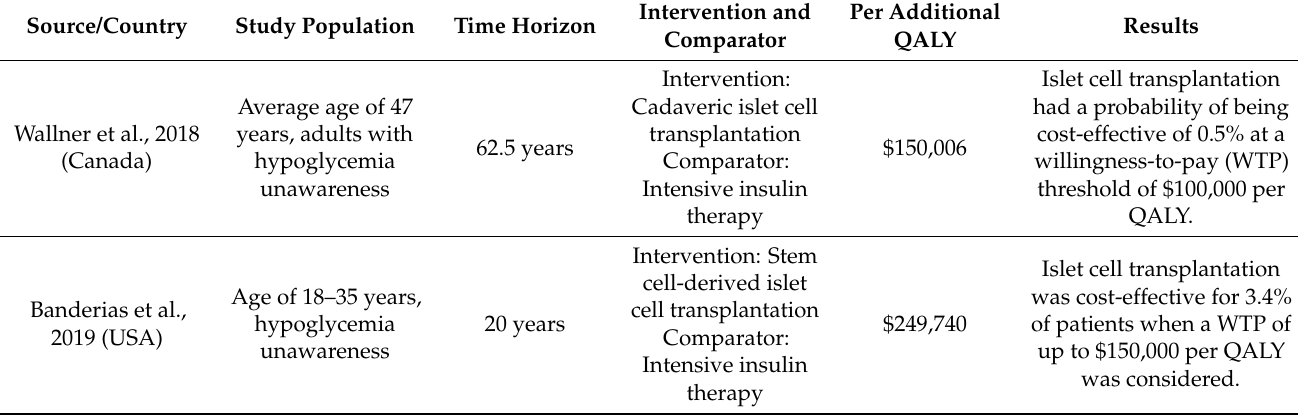
Table 2. Reported costs of pancreatic β -cell transplantation using cadaveric islets or stem cells.